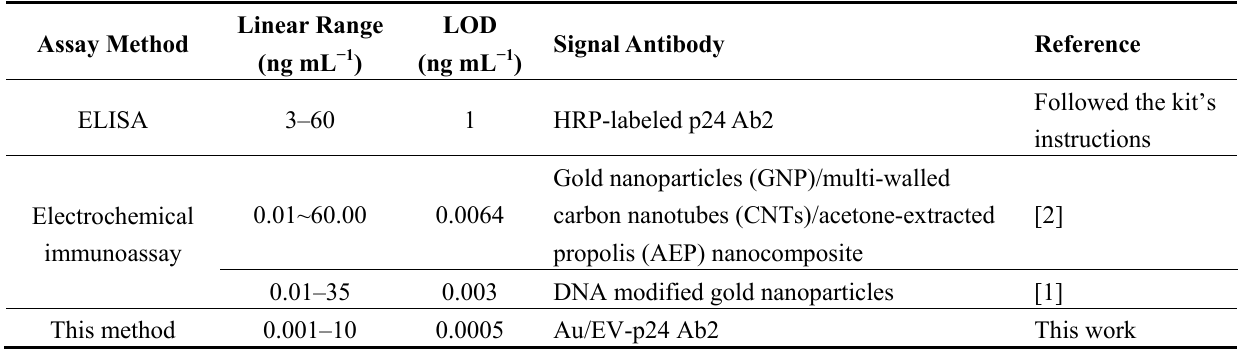
Table 1. Comparison of analytical properties of various p24 immunosensors or immunoassays. Assay